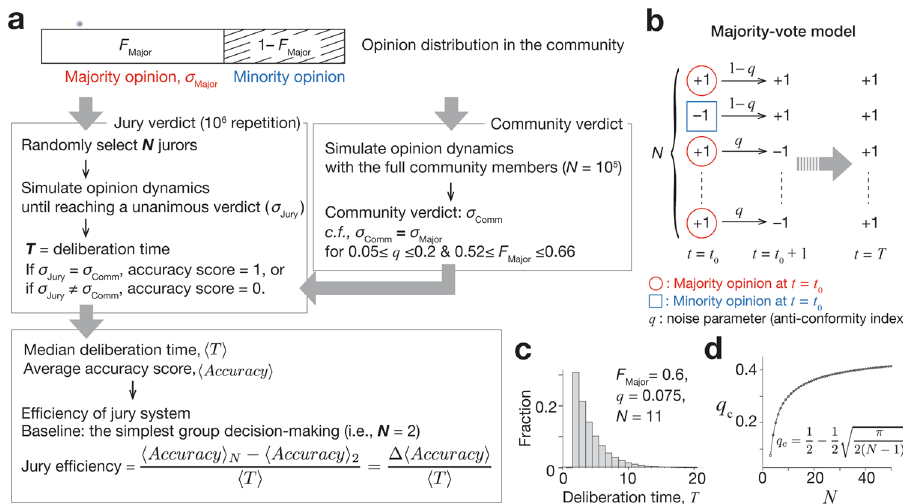
Fig. 1 Research design. a – c We evaluated the ef fi ciency of juries with N jurors by comparing the verdict accuracy with the deliberation time ( a ) using the majority-vote model with noise on a complete graph ( b ). The verdict accuracy 〈 Accuracy 〉 was de fi ned as whether the jury verdicts σ jury was the same as the verdicts hypothetically made by the full community members σ Comm . We then quanti fi ed the bene fi cial effect of N jurors on the verdict accuracy Δ 〈